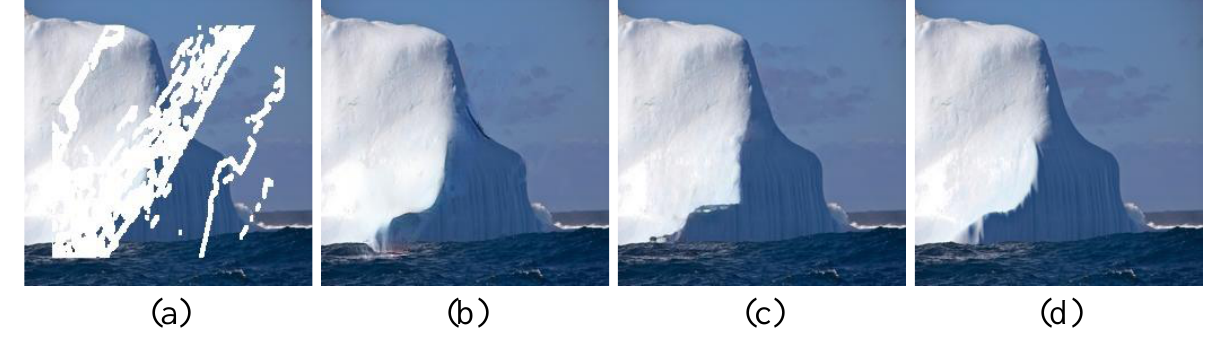
Figure 8. Abalation studies on structural attention mechanism. ( a ) Input image. ( b ) Ours w/o structural attention. ( c ) Ours. ( d ) Ground